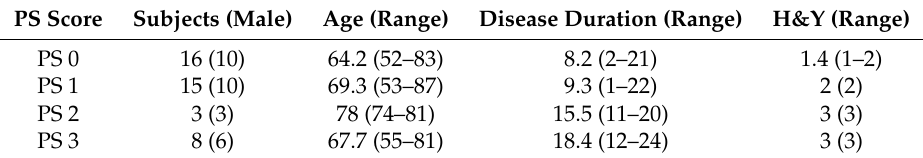
Table 2. Demographic and clinical characteristics of Parkinson’s Disease (PD) subjects divided for postural stability (PS)